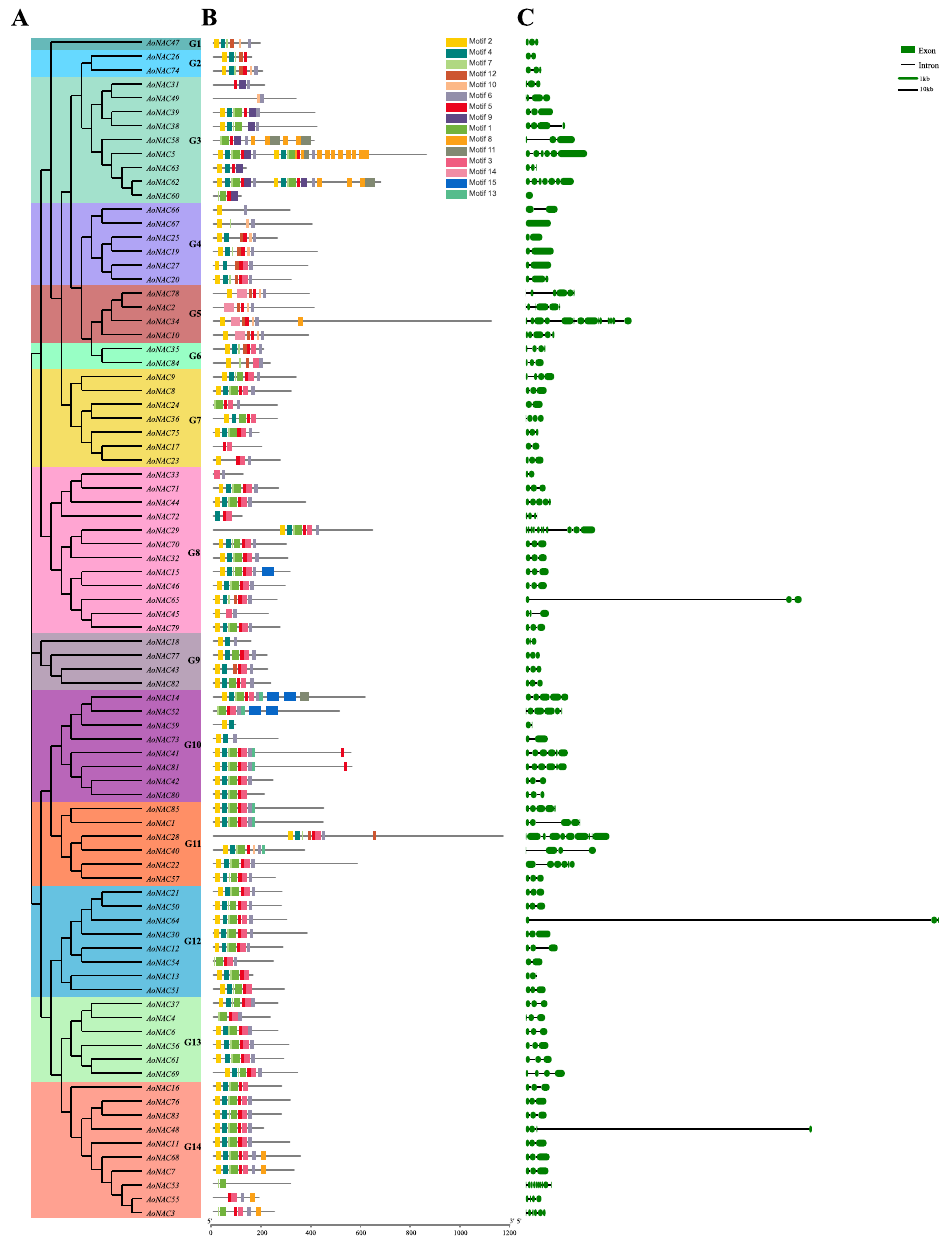
Figure 2. Phylogenetic relationship, conserved motifs, and gene structure of AoNAC genes. ( A ) An unrooted phylogenetic tree was constructed by using the ML method with 1000 bootstrap replicates based on AoNAC protein full-length sequences. ( B ) The conserved AoNAC protein motifs were predicted by the MEME program. Different colored boxes represent different motifs, and the black lines represent non-conserved sequences. The scale bar is 200 amino acids. ( C ) The intron/exon structures of AoNAC genes were displayed by using Gene Structure Display Server 2.0 program. The black line represents introns, and the green box represents exons. The intron and exon scale bars are 10 and 1 kb, respectively.